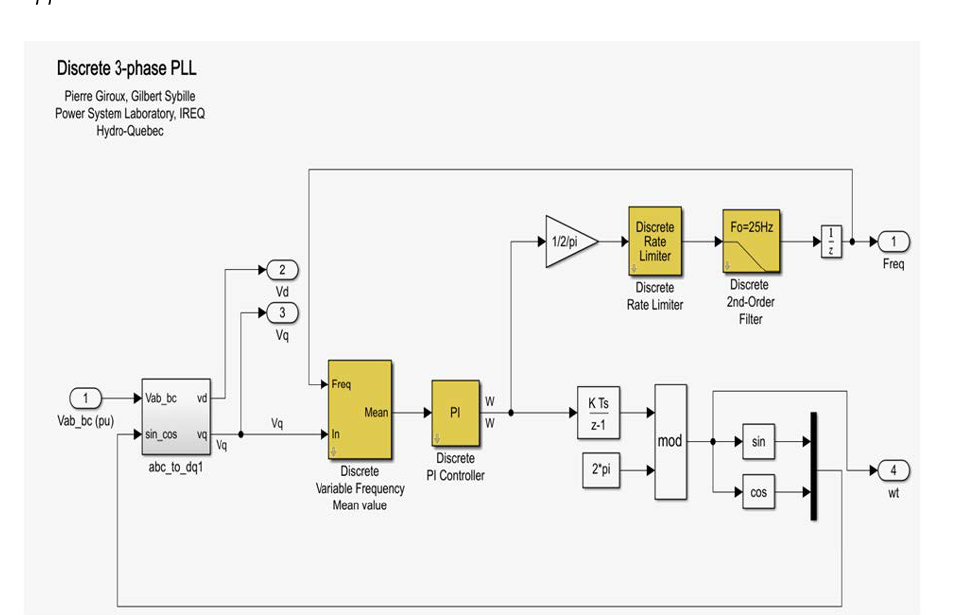
Figure A2. Discrete 3-phase Phase-Locked Loop (PLL) block.